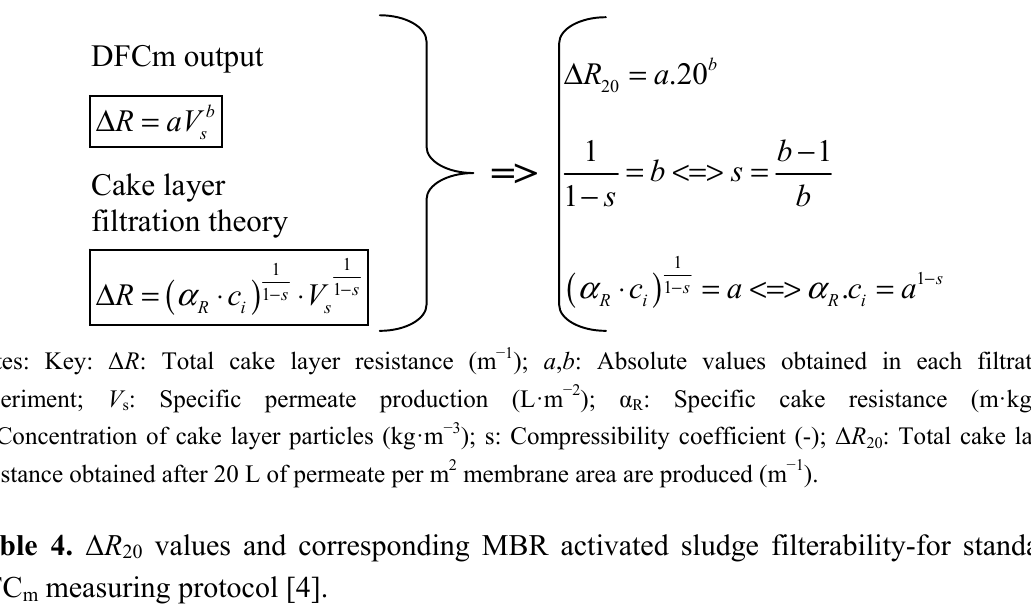
Figure 3. Processing of DFCm output (Adapted from Geilvoet [4] in Lousada-Ferreira [12]).